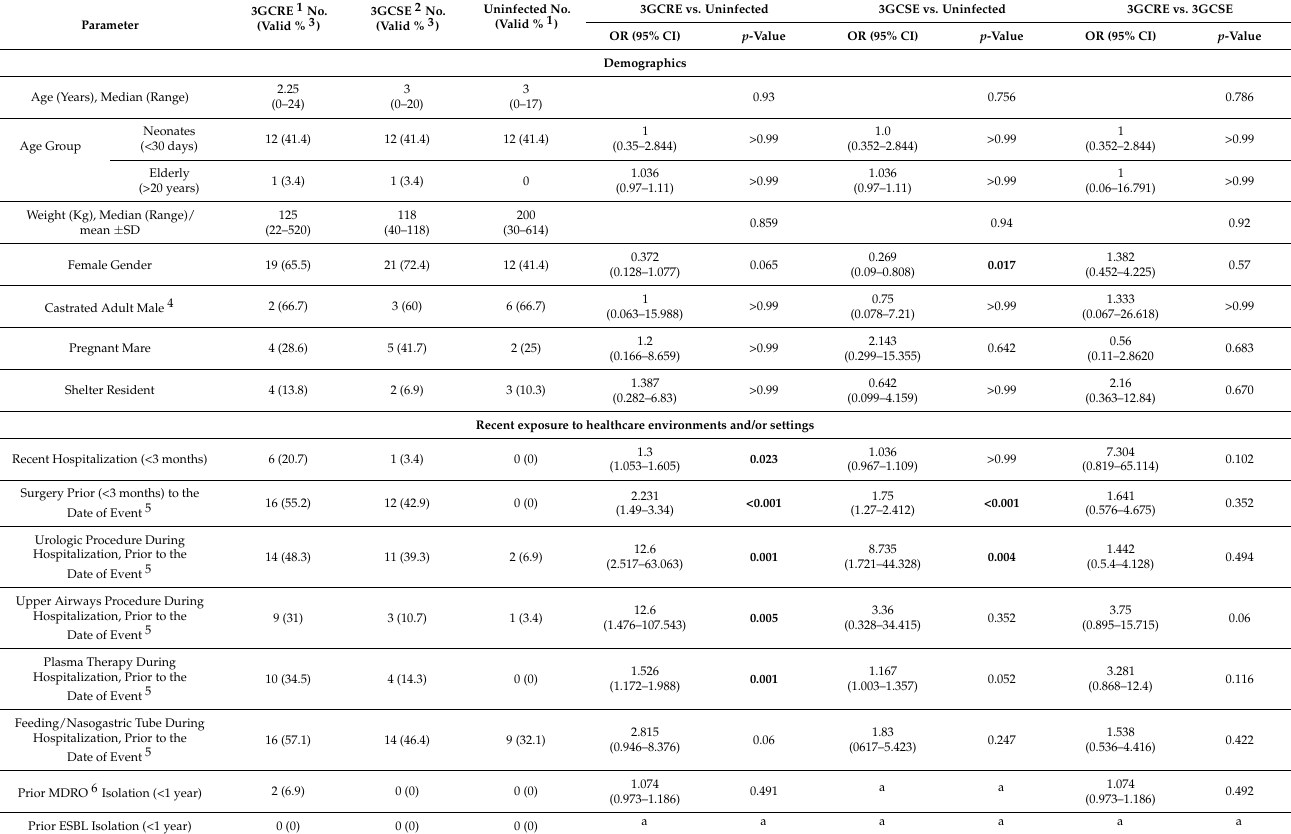
Table 1. Selected bivariable analyses comparing risk factors of patients infected with 3GCRE, patients infected with susceptible Enterobacterales and uninfected control patients ( n = 29 in each